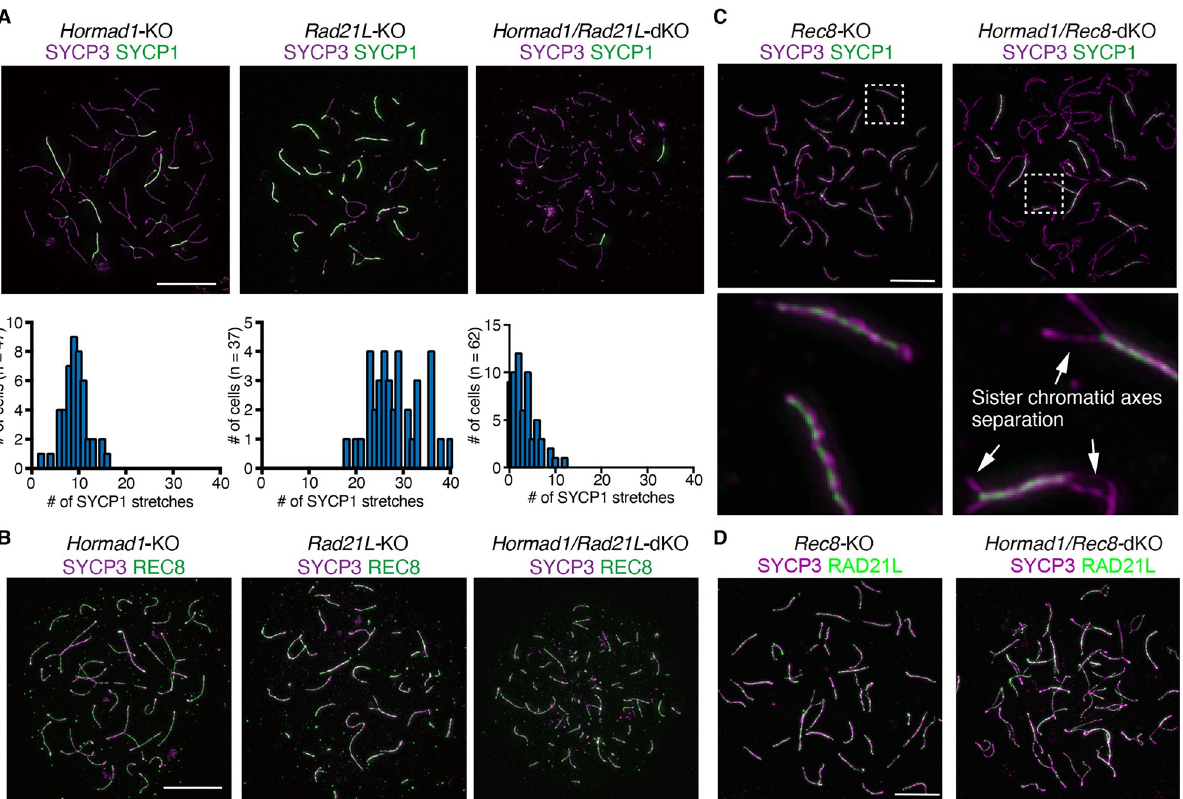
Fig 7. HORMAD1 promotes RAD21L-dependent inter-sister SC formation. (A) Spread chromatin of zygotene-like spermatocytes from Hormad1 - KO, Rad21L -KO and Hormad1/Rad21L -dKO were immunolabelled for SYCP3 (magenta) and SYCP1 (green). The frequency distribution of SYCP1 stretches are shown on the bottom. n indicates the number of the spermatocytes analyzed. (B) Spread chromatin of zygotene-like spermatocytes from Hormad1 -KO, Rad21L -KO and Hormad1/Rad21L -dKO were immunolabelled for SYCP3 (magenta) and REC8 (green). (C) Spread chromatin of zygotene-like spermatocytes from Rec8 -KO and Hormad1 / Rec8 -dKO were immunolabelled for SYCP3 (magenta) and SYCP1 (green). Enlarged images are shown on the bottom. Arrows indicate sister chromatid axis separations. (D) Spread chromatin of zygotene-like spermatocytes from Rec8 -KO and Hormad1 / Rec8 -dKO were immunolabelled for SYCP3 (magenta) and RAD21L (green). Scale Bars: 10 μ m.